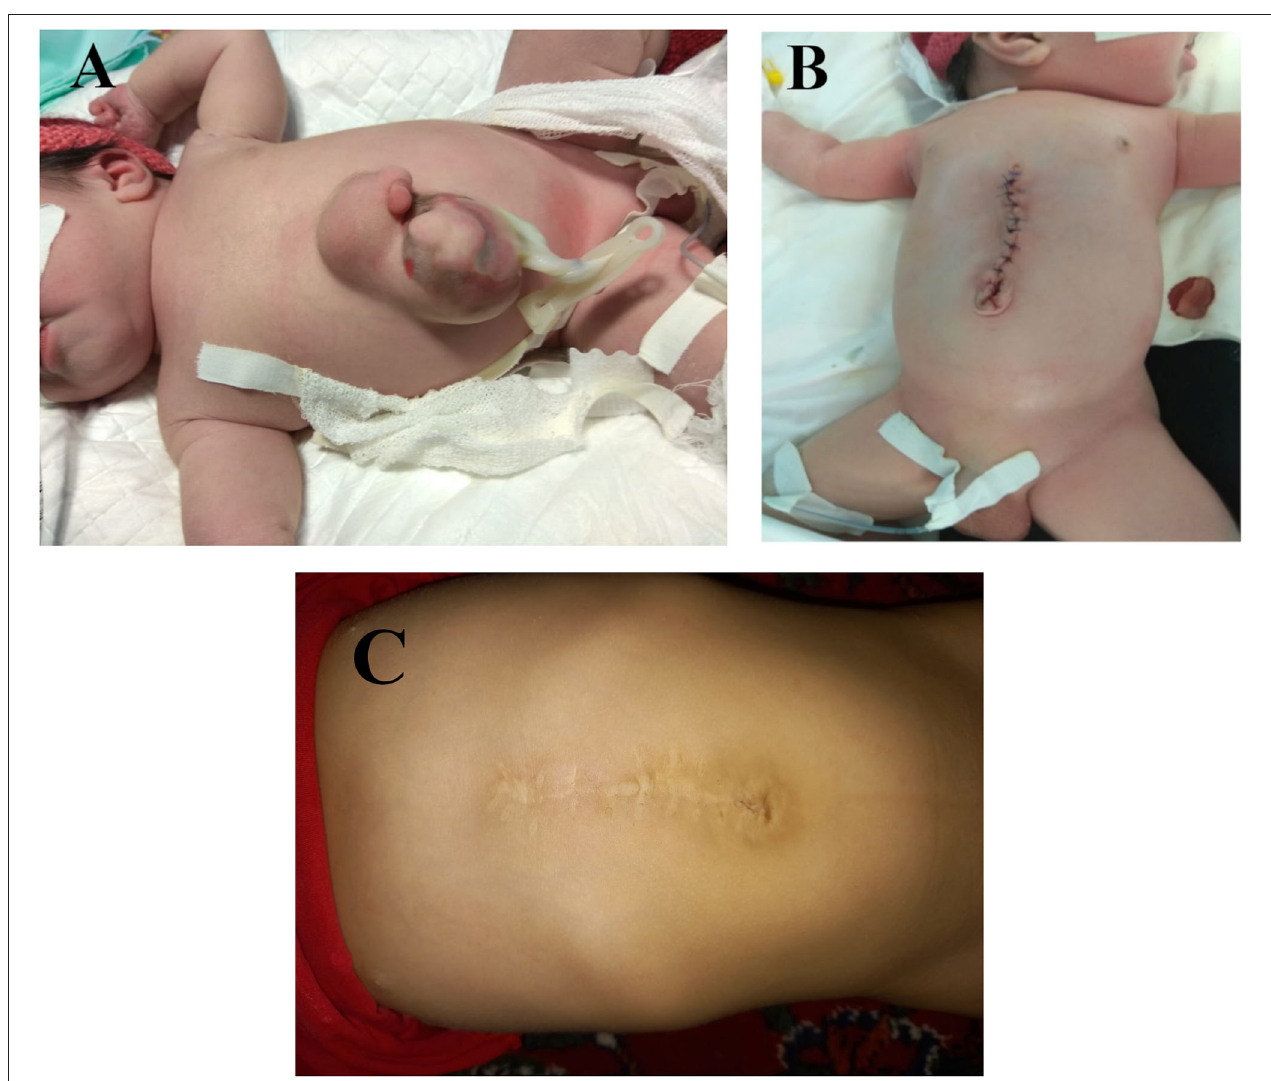
FIGURE 2 | (A) A defect of the anterior abdominal wall in the umbilical area measuring 4.0 × 5.0 cm, covered with a membrane and skin along the periphery. In the center of the membrane there was an area of unchanged skin with the size of 2.0 × 2.0 cm. (B) The surgical wound on the 3rd postoperative day. (C) The postoperative scar on the recent follow